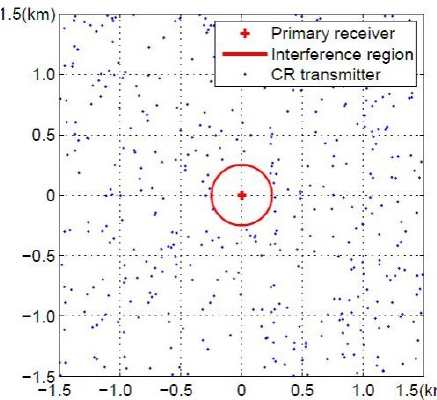
Figure 5. Geo-location-based interference